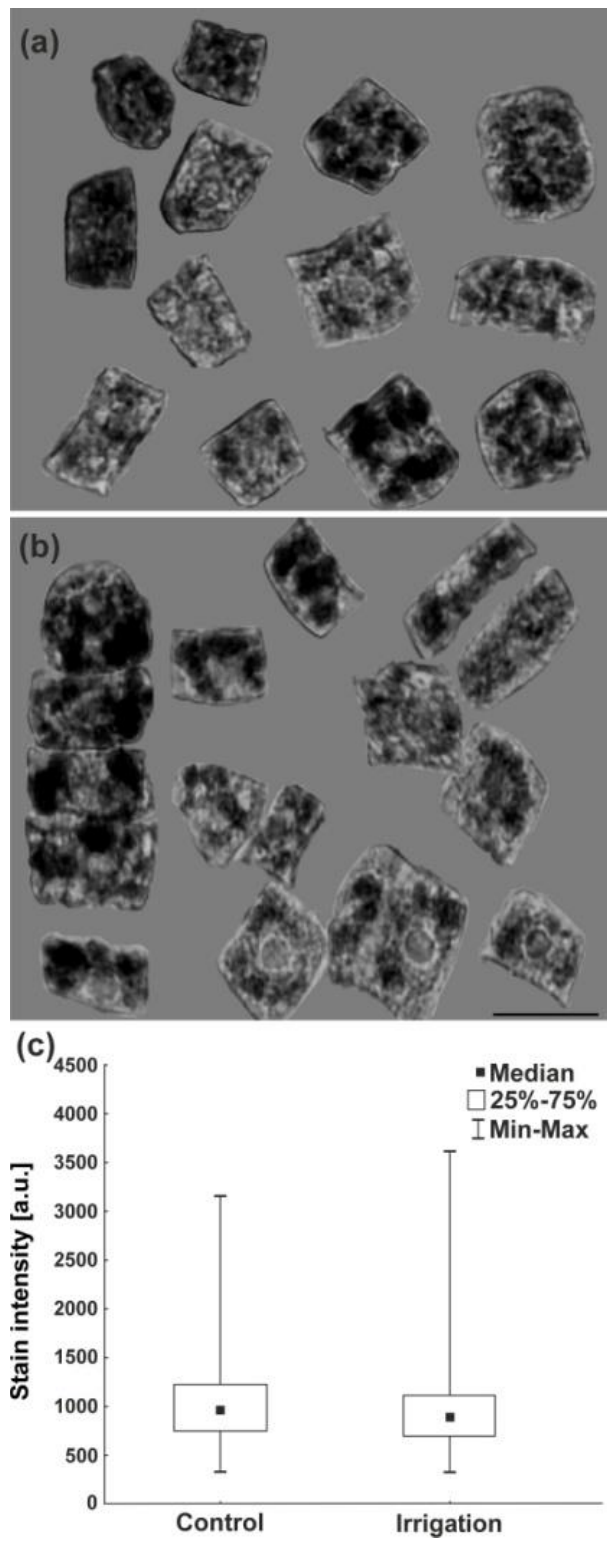
Figure 8. Identification of H 2 O 2 in the form of dark 3,3-diaminobenzidine (DAB) polymers and the level of H 2 O 2 in the cells of embryonic roots deriving from lupine seeds. ( a ) Not irrigated—control plants. ( b ) Irrigated plants. Scale bar 20 μm; ( c ) stain intensity (arbitrary units) in these cells. Statistical significance between median values was assessed with the Mann–Whitney U test ( p < 0.01). Median values are statistically insignificant .